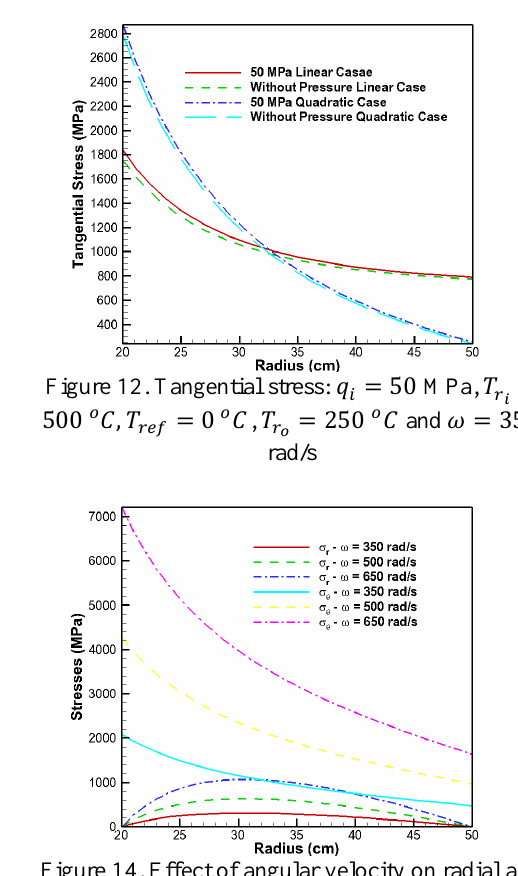
Figure 14. Effect of angular velocity on radial and = 𝑟 𝑖